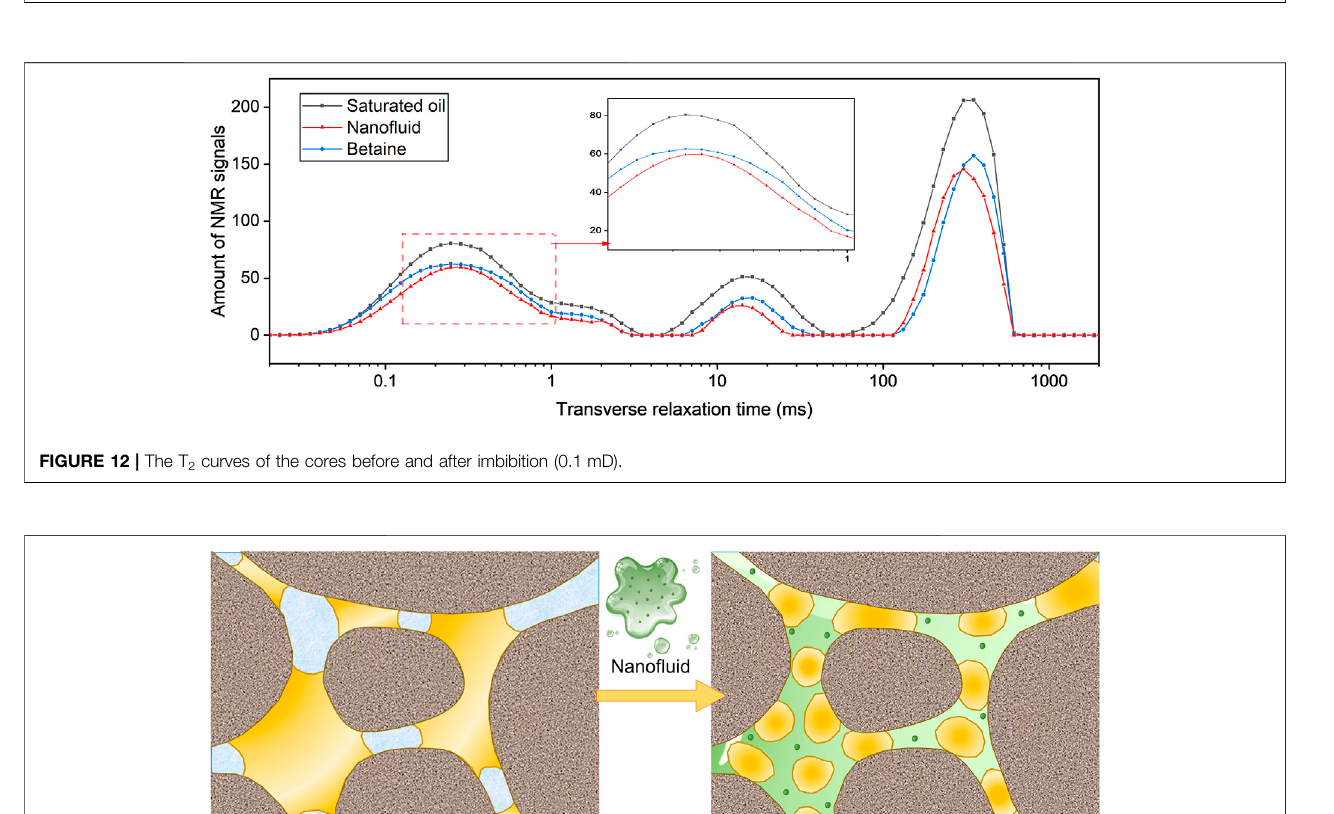
FIGURE 11 | The T 2 curves of the cores before and after imbibition (1 mD).